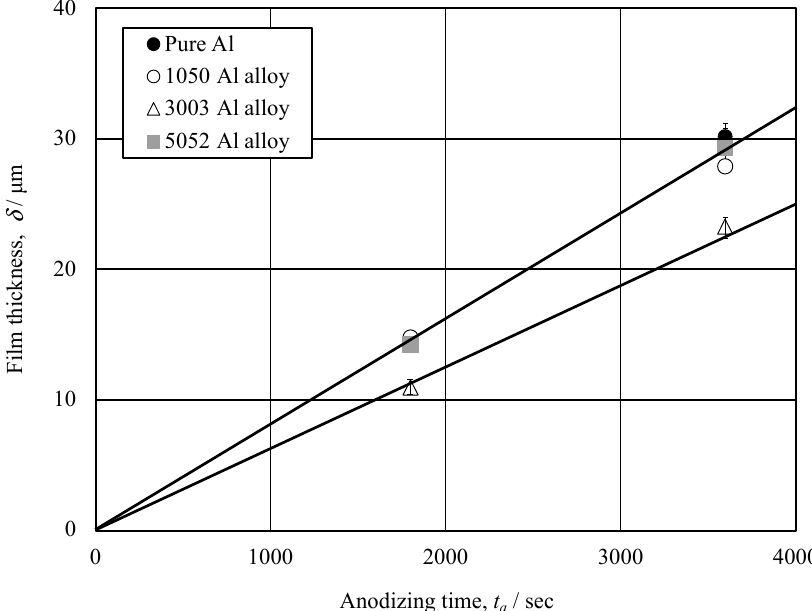
Figure 8. Relationship between film thickness, δ , and anodizing time, t a , obtained for pure Al and Al alloys. Anodizing conditions are described in Figure 3.